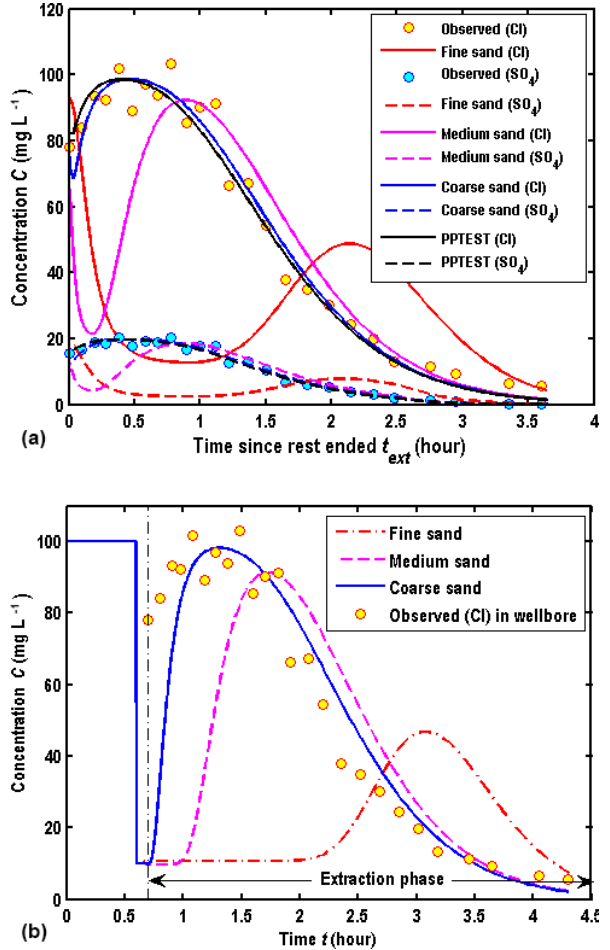
Figure 12. BTCs for the different porous media with a piece-wise linear function to describe chemical reactions: (a) Cl 1 − and SO 2 − in the aquifer at r = r w + 0 . 15m, (b) Cl 1 − in the wellbore.